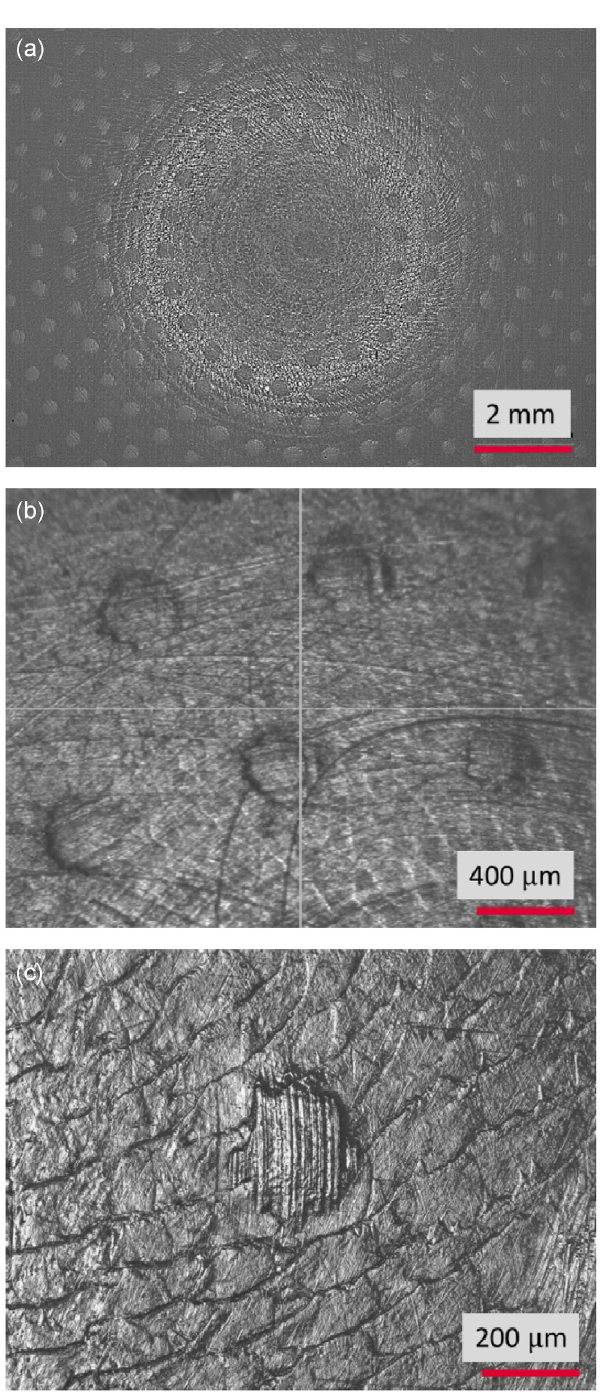
Fig. 2 Macroscopic image of (a) the dimpled cup and (b) group of the dimples taken by laser microscope. (c) Detail of the dimple taken by confocal